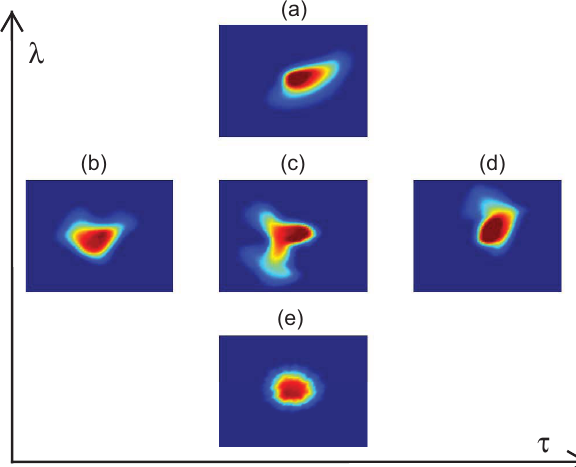
Fig. 2. Phytoplankton patches observed for different pairs of time and length scales ( τ,λ ) for the Gaussian flow, Eqs. (2–4). Length scale increases from bottom to top, and the temporal correlation scale from left to right. Note the larger patch size for inter- mediate values of τ and λ . Set of parameters: G( 0 , 0 ) = 225, N x = N y = 128. Length and time scales (log 10 (τ/T ), log 10 (λ/L)